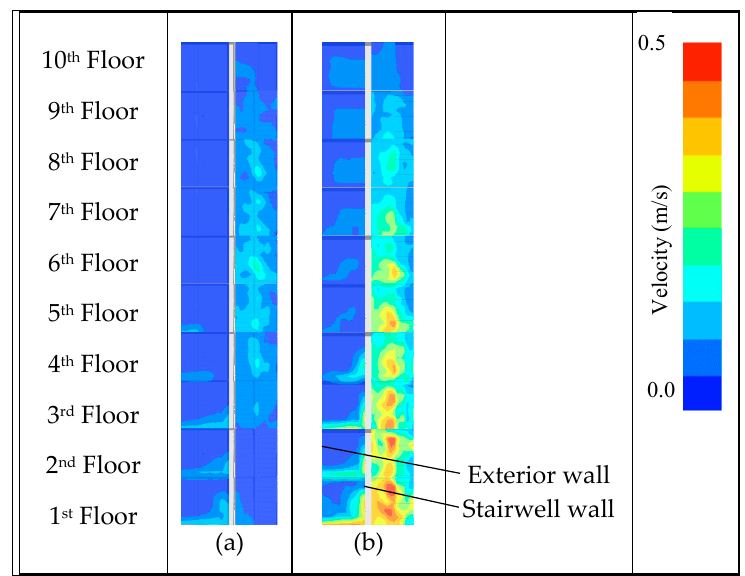
Figure 16. Cross-section of building showing airflow velocity entering stairwell for simulations with (a) evenly distributed openings and (b) bottom opening.